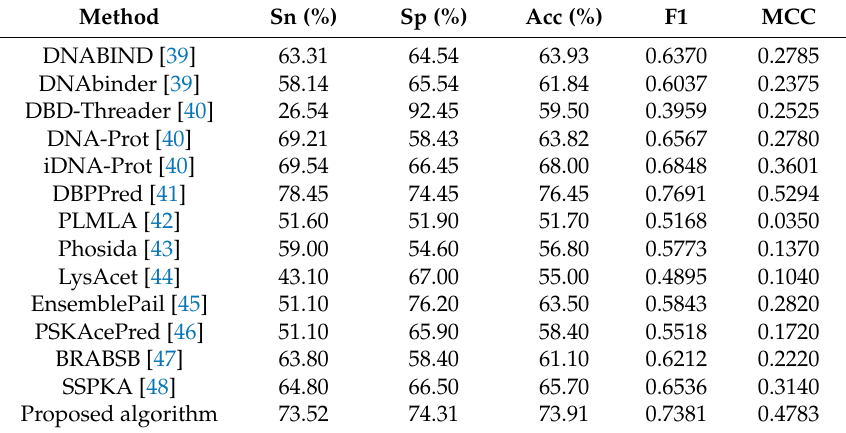
Table 5. Performances of different methods in M. musculus .